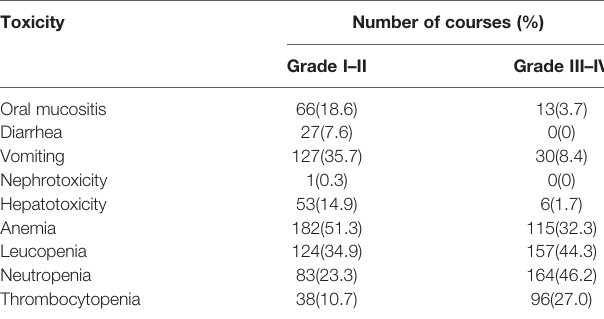
TABLE 2 | Prevalence of HD-MTX-related toxicities in children with